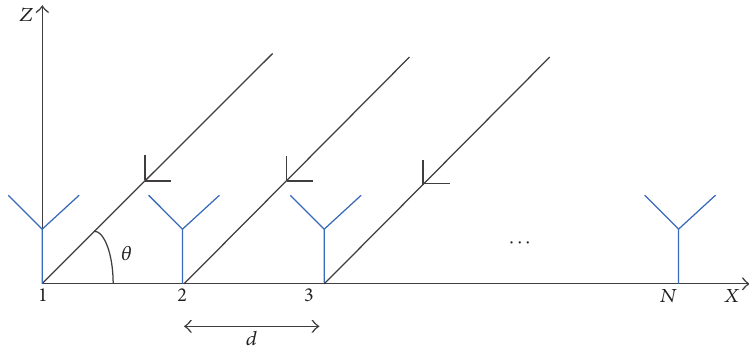
Figure 1: The linear antenna array